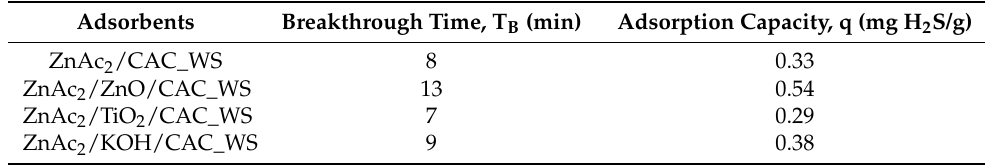
Table 1. Adsorption capacity of CS/CAC_WS